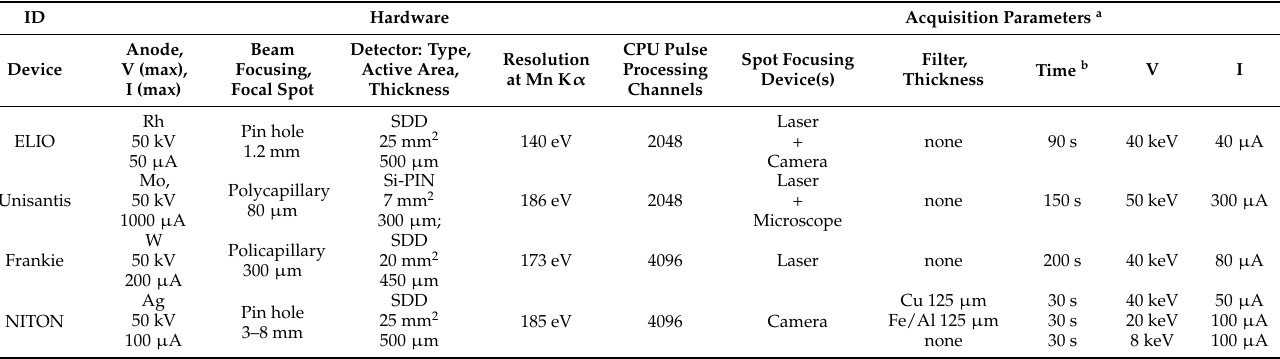
Table 2. Details of the XRF units involved in this study. V is the acceleration voltage of the X-ray source, and I is the intensity of the